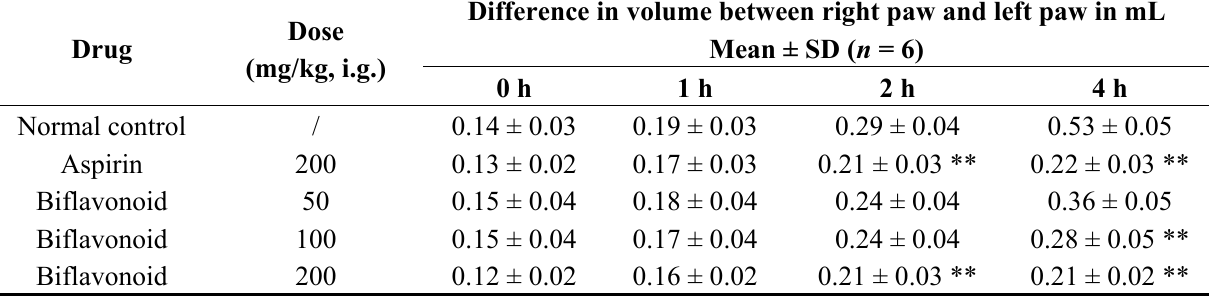
Table 2. Effect of the biflavonoid on carrageenin-induced paw oedema in rats. Difference in volume between right paw and left paw in mL Dose Mean ± SD ( n = 6) Drug (mg/kg, i.g.) 0 h 1 h 2 h 4 h Normal control / 0.14 ± 0.03 0.19 ± 0.03 0.29 ± 0.04 0.53 ± 0.05 Aspirin 200 0.13 ± 0.02 Biflavonoid 50 0.15 ± 0.04 Biflavonoid 100 0.15 ± 0.04 0.17 ± 0.04 0.24 ± 0.04 0.28 ± 0.05 ** Biflavonoid 200 0.12 ± 0.02 0.16 ± 0.02 0.21 ± 0.03 ** 0.21 ± 0.02